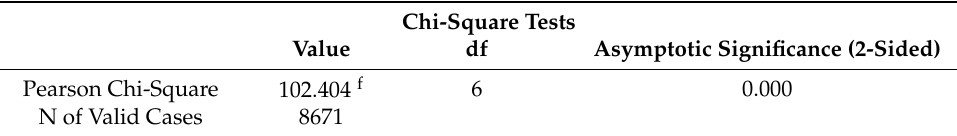
Table 17. Chi-square test (enterprise size vs. change in the ROE 2021 profitability indicator). Source: own research.